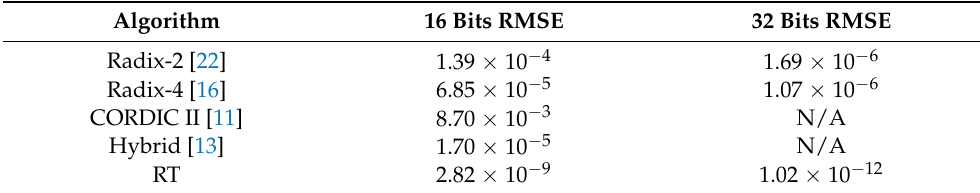
Table 1. Comparison of different algorithms to generate cosine waveform.